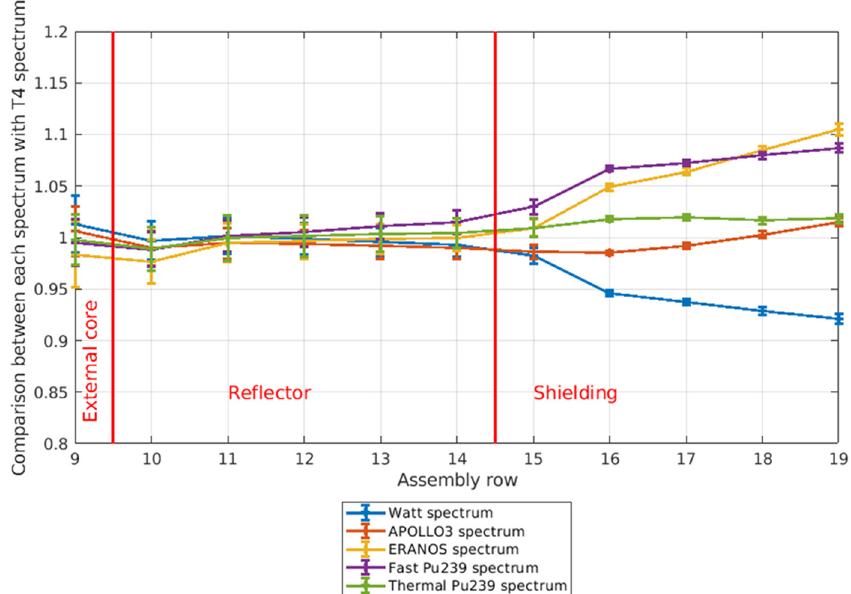
Fig. 11. Radial fl ux pro fi le comparison between the shielding calculations with variance reduction techniques using each fi ssion spectrum.